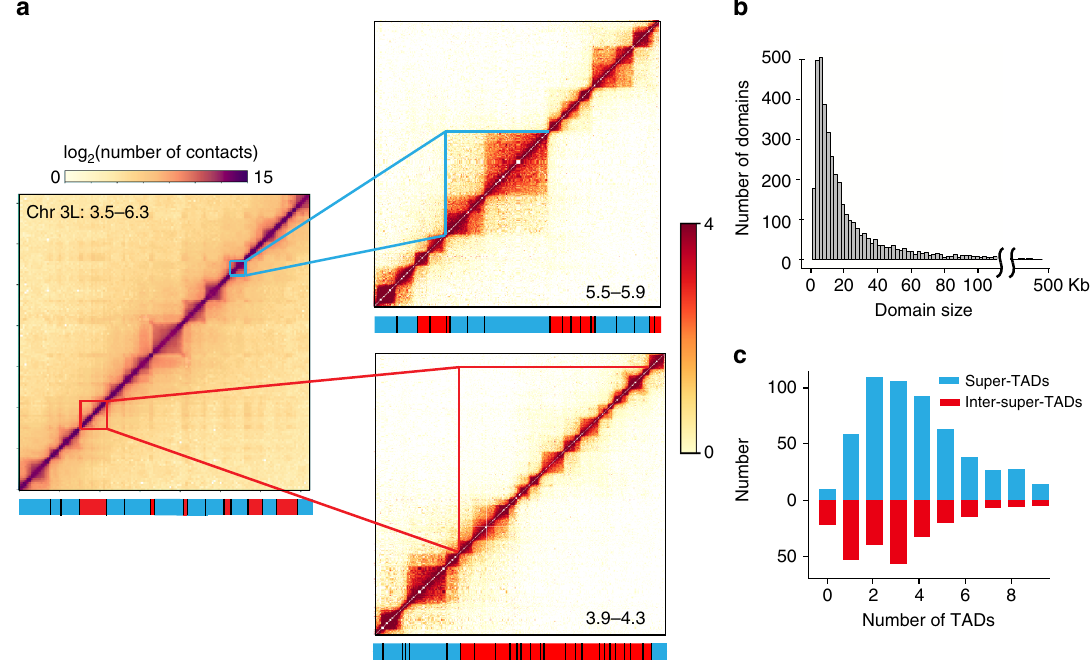
Fig. 1 The Drosophila genome is fully partitioned into contiguous TADs including within previously annotated “ inter-TADs ” regions. a Heatmaps from the left arm of chromosome 3. The left panel shows a heatmap of a 2.8 Mb region of this arm at 20 kb resolution, revealing well-de fi ned super-TADs (blue bars at the bottom) and inter-super-TADs (red bars at the bottom), consistent with previous fi ndings 19 . At higher resolution (~200 bp), the heatmap shows that both the super-TADs (right upper panel) and the inter-super-TADs (right lower panel) are composed of small contiguous TADs. The blue (red) bars in these panels now refer to TADs within the super-TADs (inter-super-TADs). b The size distribution of the TADs annotated from the fragment-limited resolution map. The median size of the TADs is 13 kb. c The number of TADs within the super-TADs (blue bars) and inter-super-TADs (red